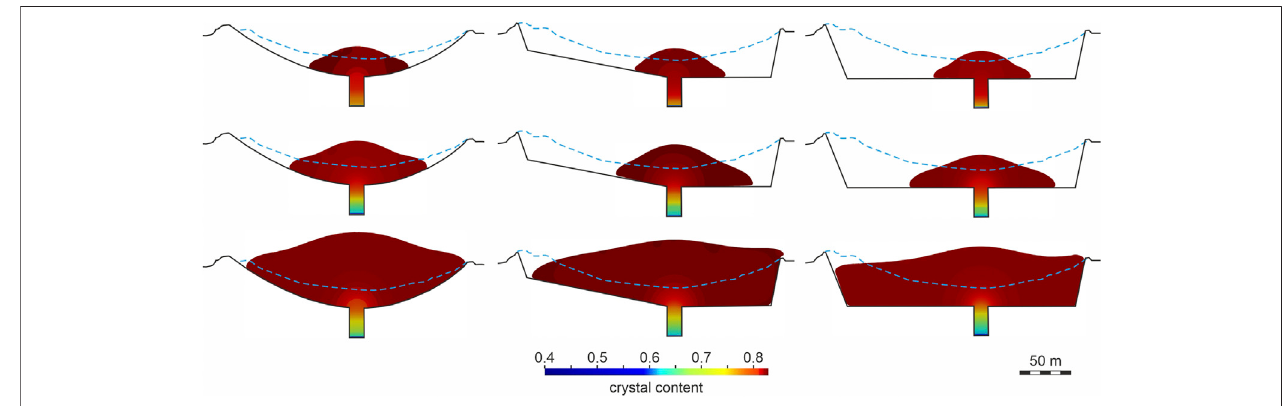
FIGURE8| Themodeledcrystalcontentattimesof2007/11/01 (upperpanels) ,2008/05/01 (middlepanels) ,and2009/04/01 (lowerpanels) inexperiments4 (left column) , 5 (middle column) , and 6 (right column) .